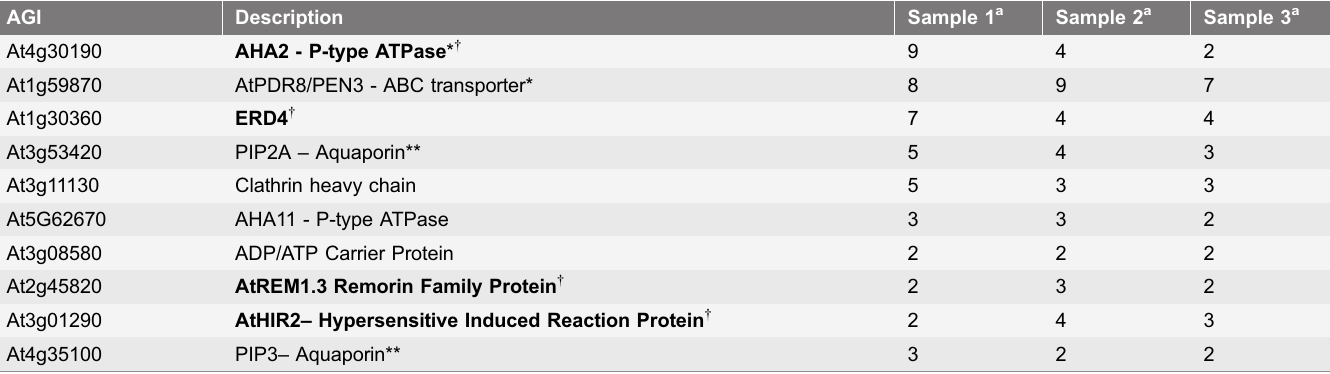
Table 1. Proteins of the HopF2 complex identified by mass spectrometry.